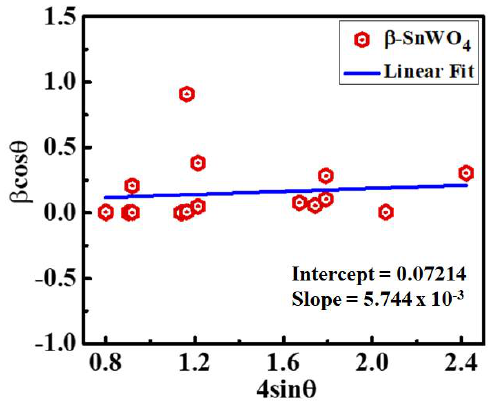
Figure 3. Williamson–Hall (W–H) plot of β -SnWO 4